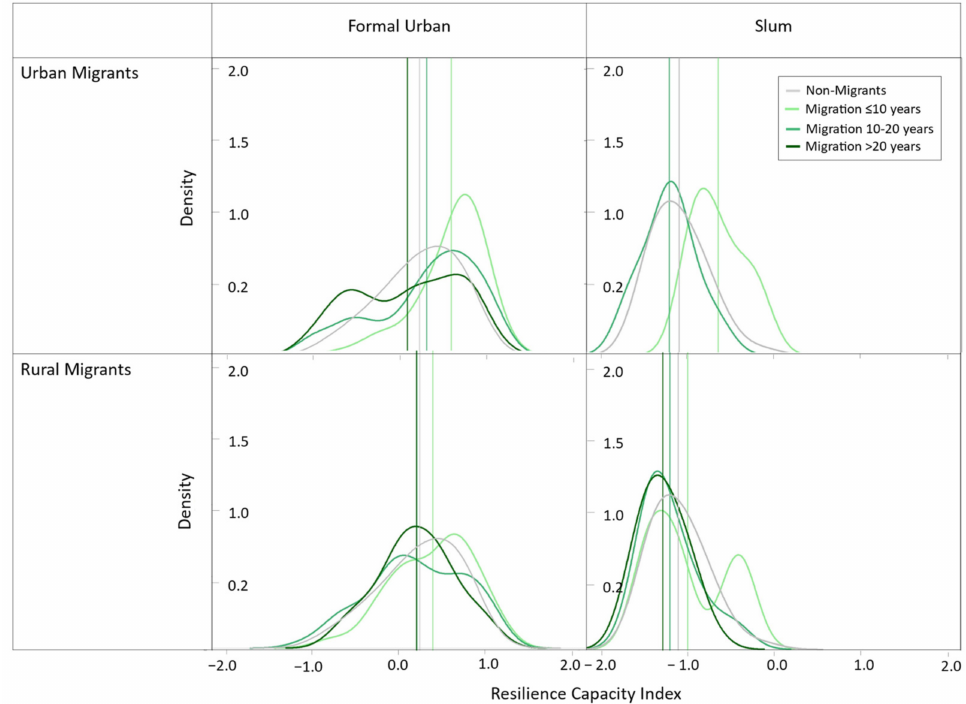
Figure 7. Resilience matrix displaying kernel density estimation of RCI of sub-groups based on the migration characteristic time since